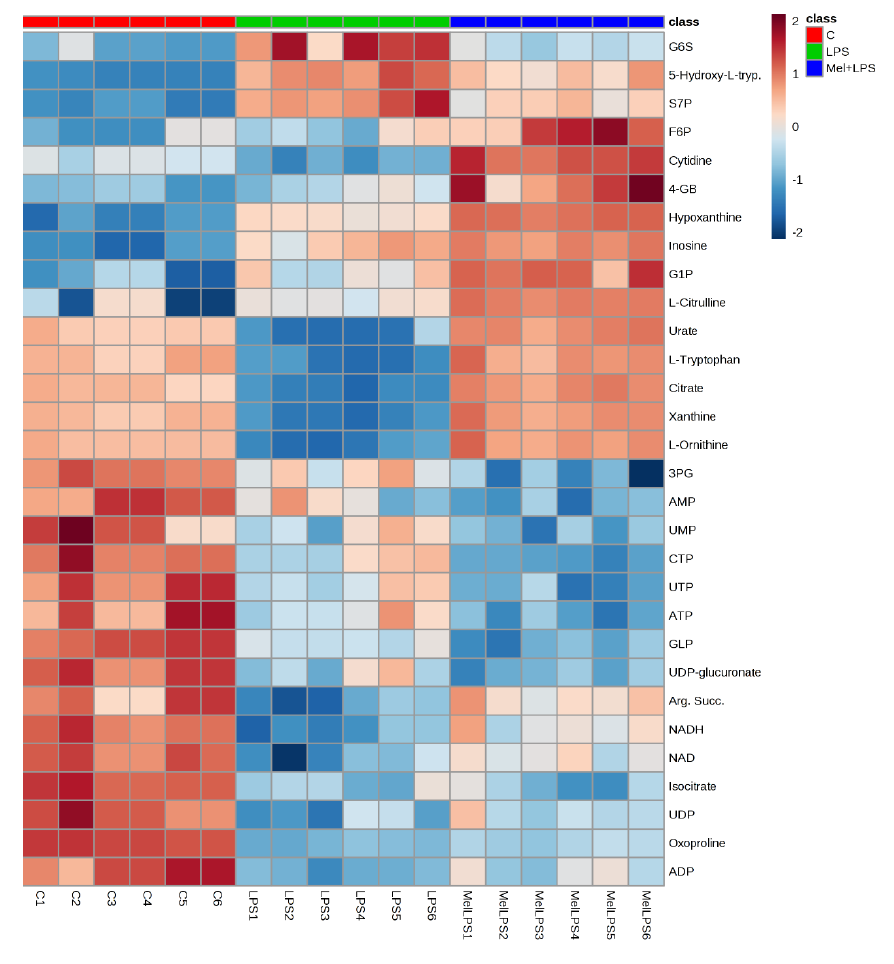
Figure 8. Heat map showing the top 30 significant putative metabolites among control (C), LPS, and melittin + LPS (Mel + LPS) using one-way ANOVA. The data are displayed on a log 2 scale. The differences in colour shades represent intensities of the metabolites vs. sample observations.